Question: What style of plot is this figure drawn as?
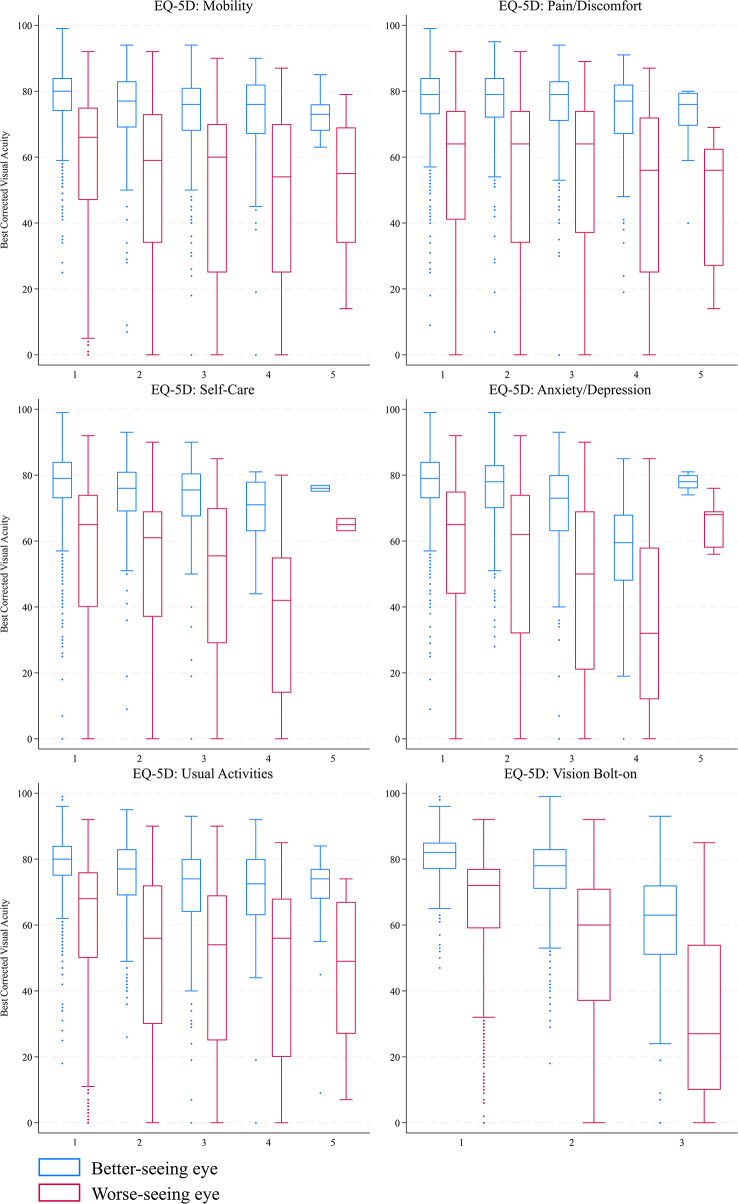
Answer: box